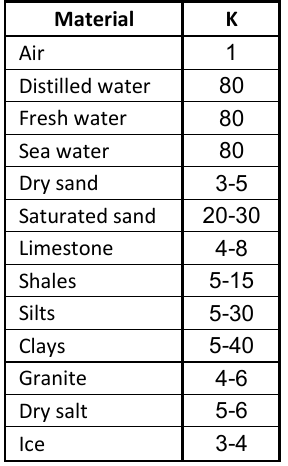
Table 1. Typical relative permittivity observed in common geological materials (Butler,